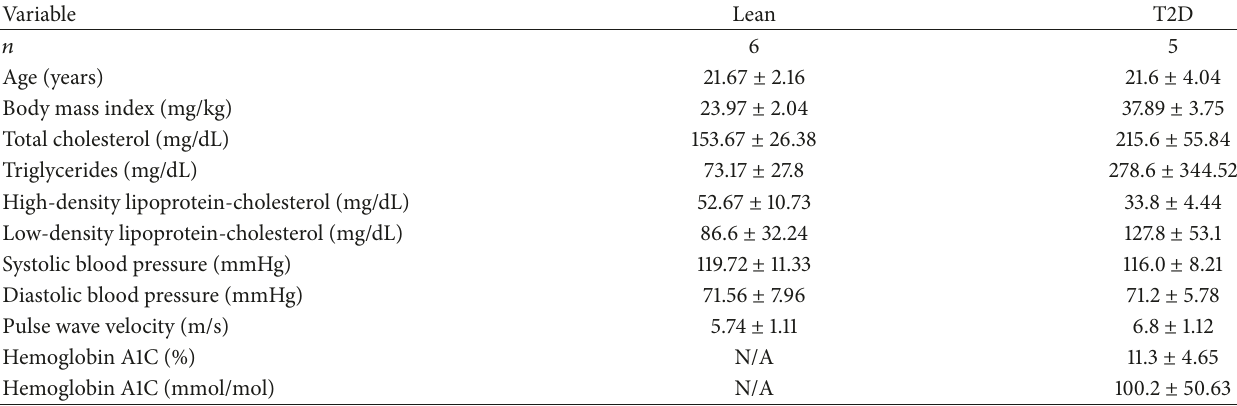
Table 1: Study cohort